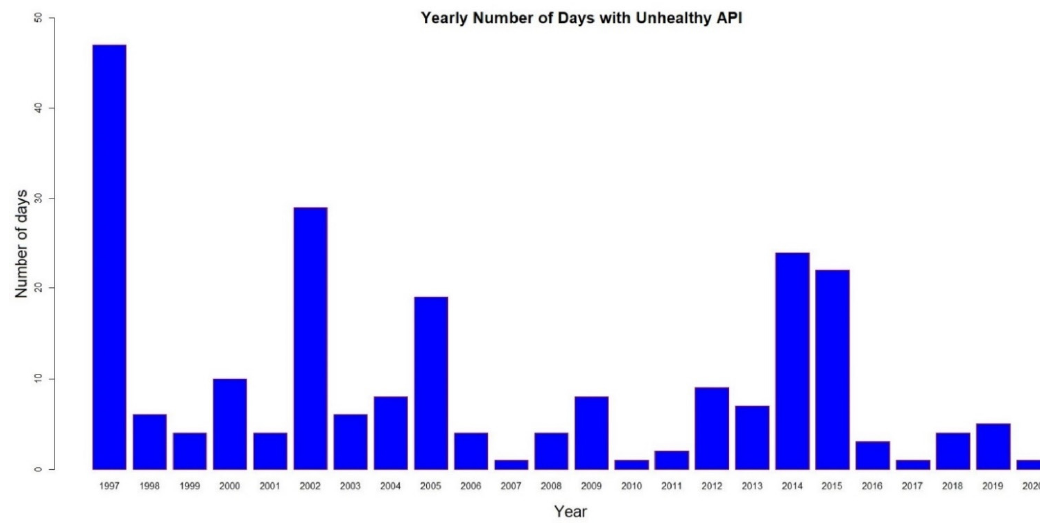
Figure 6. Bar plot for yearly number of days with unhealthy API.